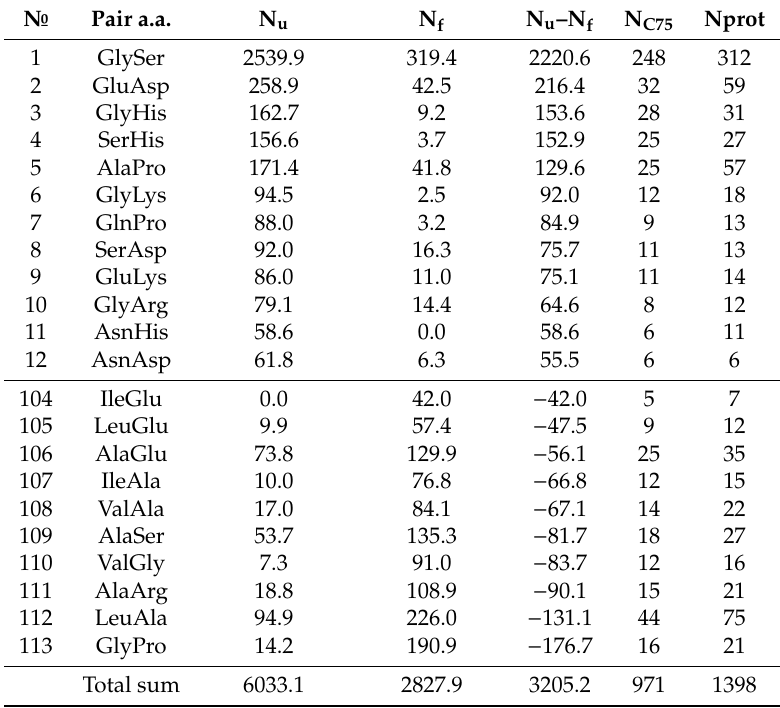
Table 2. Comparison of data for the di ff erent AC2